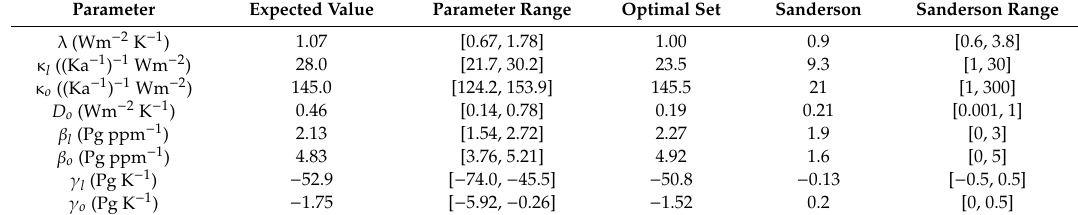
Table 3. Parameters’ uncertainty by random emission and temperature input.